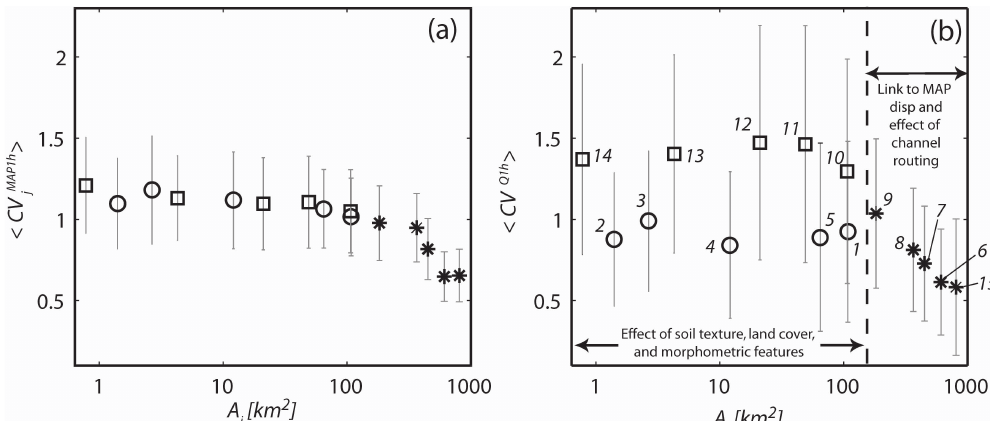
i (index j = 1 ,..., 15 refers to the basins listed in Table 1), as a function of Fig. 5. (a) Variability of ensemble QPFs, quantified by h CV MAP1h j i , as a function of A j . Vertical bars indicate the standard deviations of the the basin size, A j . (b) Variability of ESFs, quantified by h CV Q1h j 100CVs. The three different markers (circle, square and asterisk) are used to indicate the three groups of sub-basins as explained in the